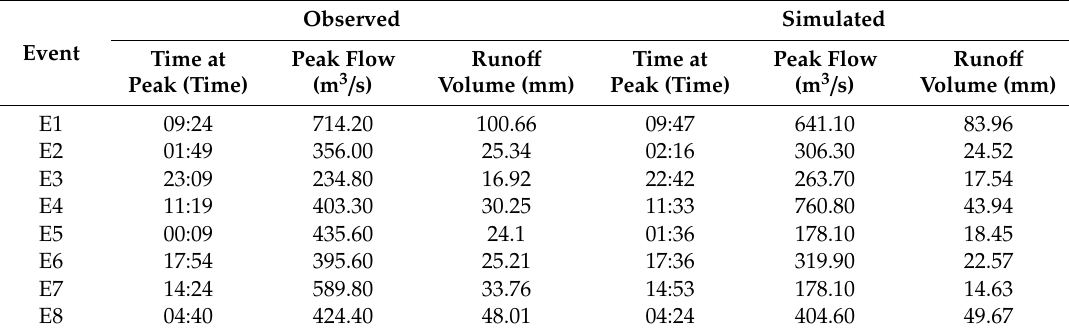
Table 4. Observed and simulated peak flow, time at peak, and runo ff volume for events